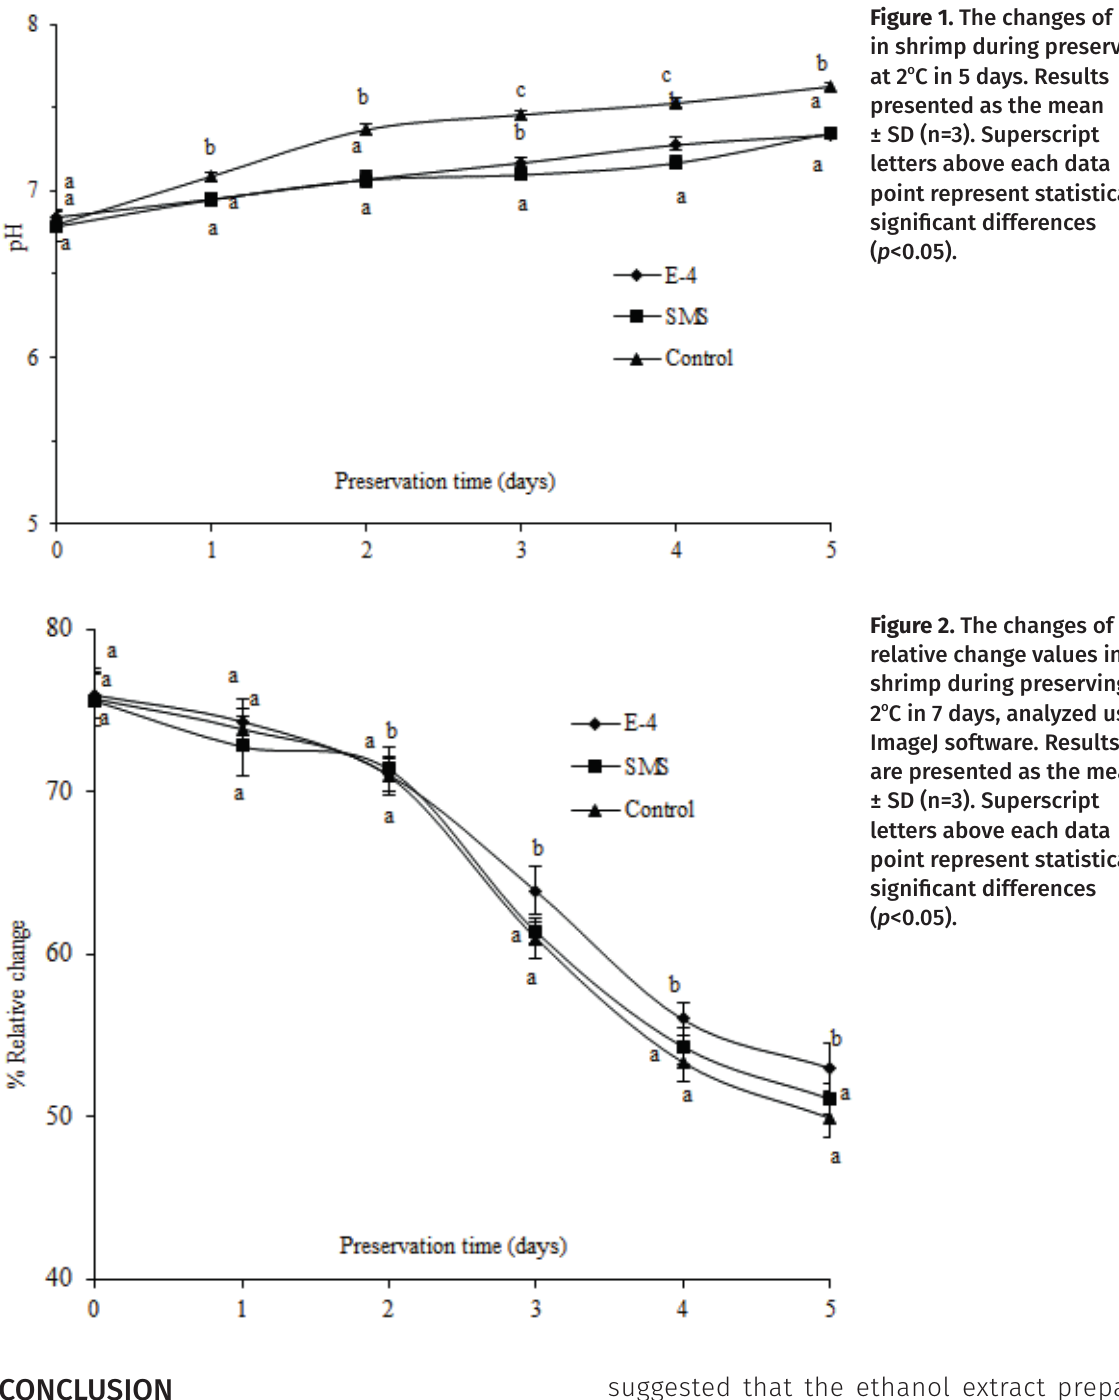
Figure 2. The changes of % relative change values in shrimp during preserving at 2 o C in 7 days, analyzed using ImageJ software. Results are presented as the mean ± SD (n=3). Superscript letters above each data point represent statistically signifi cant differences ( p